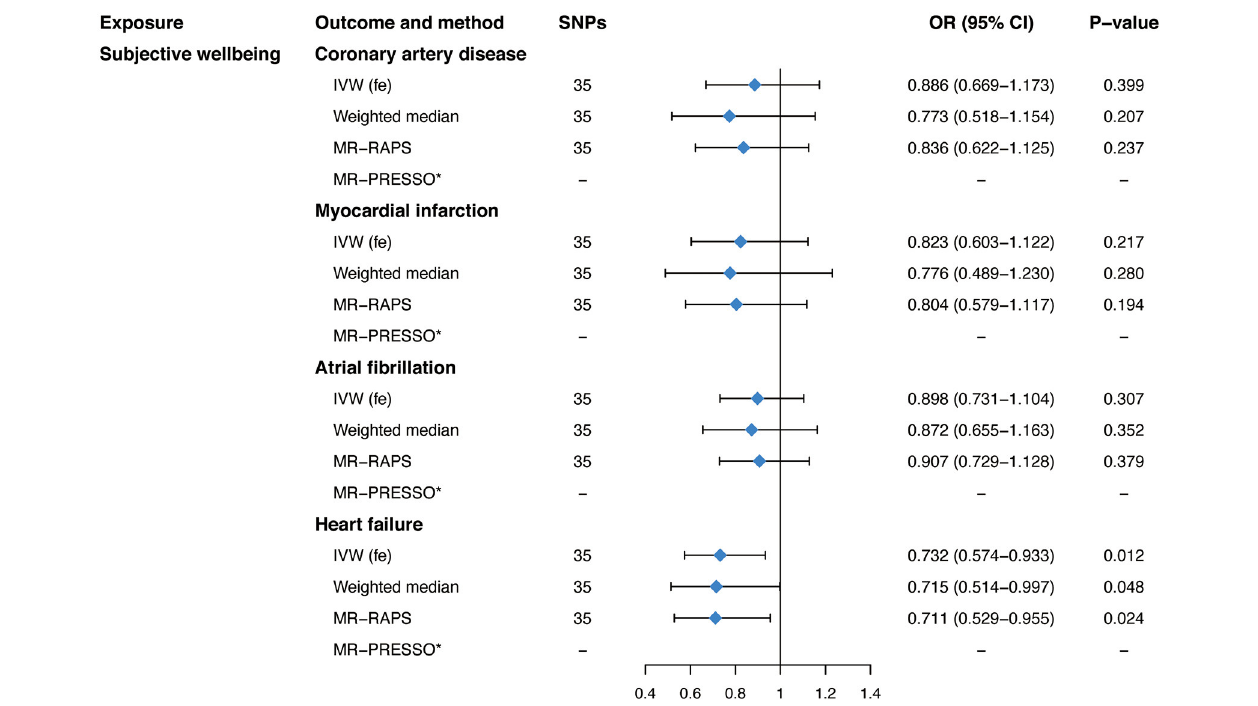
FIGURE 3 | Mendelian randomization estimates of genetically predicted subjective well-being on four cardiovascular diseases. SNPs, single-nucleotide polymorphisms; OR, odds ratio; CI, confidence interval; IVW (fe), fixed-effects inverse-variance weighted; IVW (mre), multiplicative random-effects inverse-variance weighted; MR-RAPS, Mendelian randomization-robust adjusted profile score; MR-PRESSO, Mendelian randomization pleiotropy residual sum and outlie.